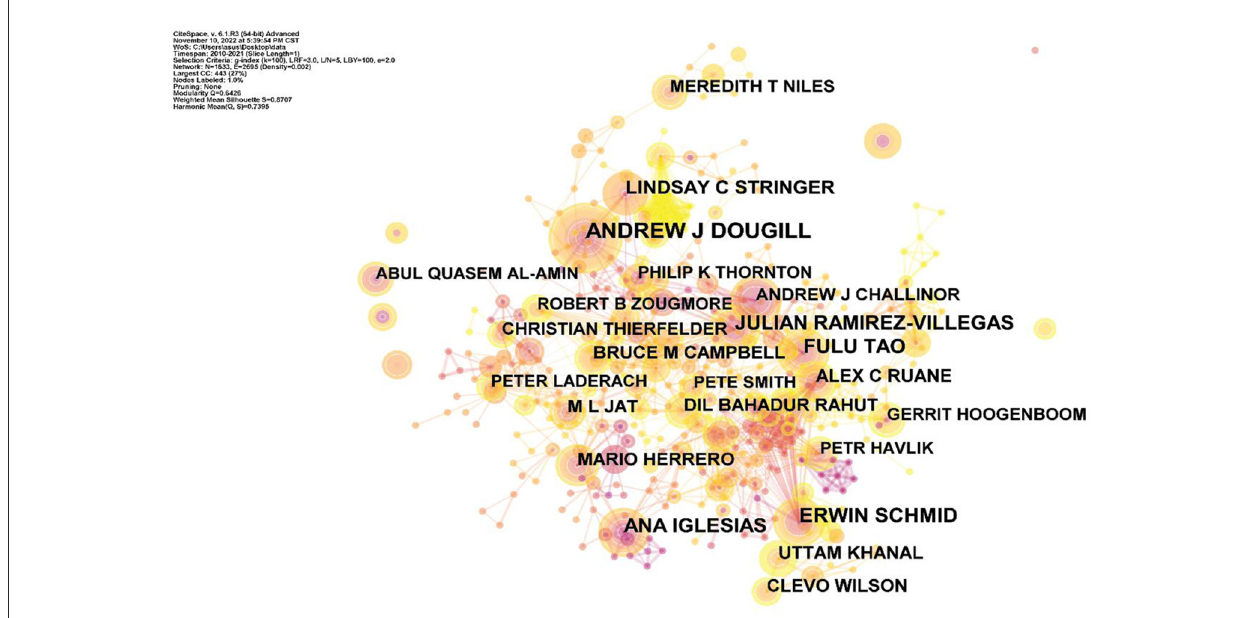
FIGURE5 A visualization of the author cooperation network. Each node represent an author, the larger the node, the more publication that author has. The line represent the connection between authors, the thicker the line, the closer relationship and the lighter color of the line, the later connection.